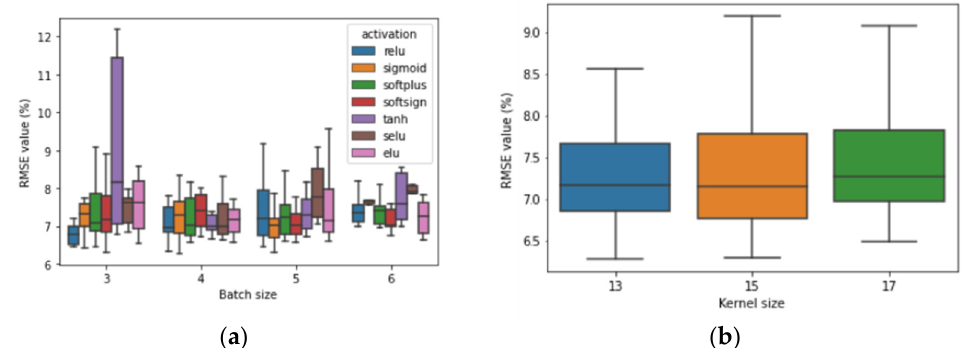
Figure 10. Boxplots of the RMSE values over ( a ) different batch sizes per activation function, and ( b ) different kernel sizes.